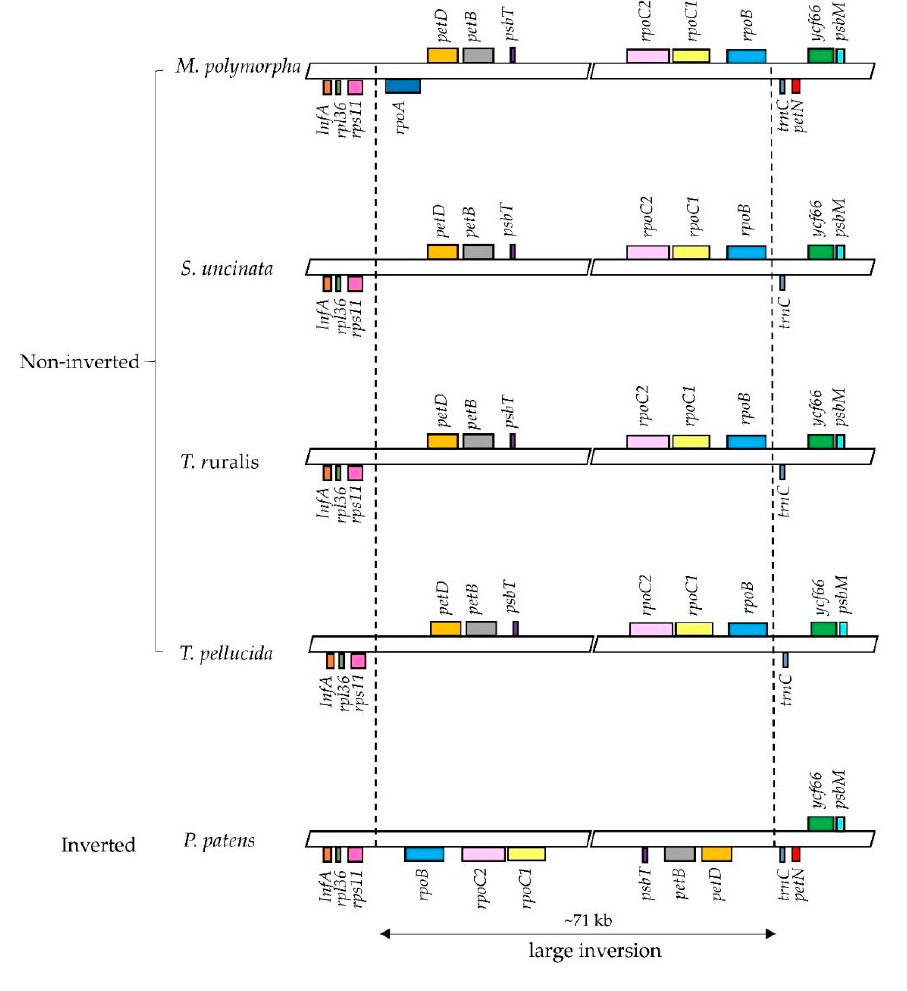
Figure 4. Comparison of the large inversion in the LSC region among six bryophytes plastomes. In comparative LSC region alignment of rpoA , petN coding regions from M. polymorpha , S. uncinata , T. ruralis , T. pellucida and P. patens . The inverted-arrangement of 71 kb fragment was only detected for P. patens .